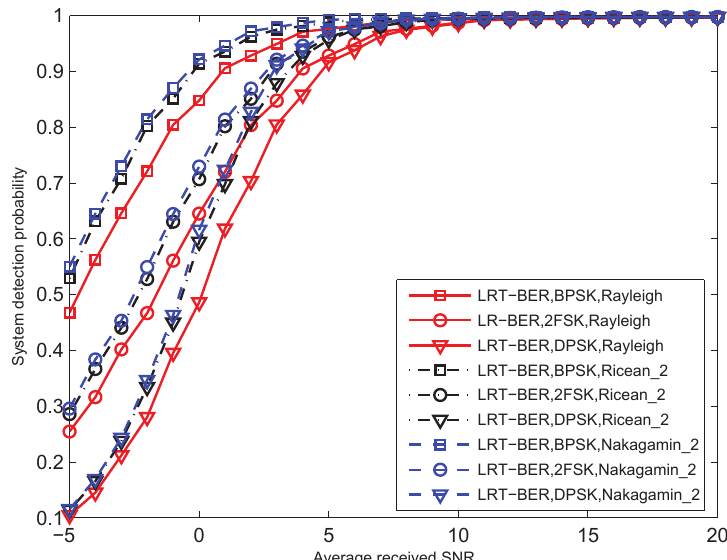
Figure 4. Detection probability of the LRT-BER fusion rule as a function of different received SNRs for BPSK, 2FSK and DPSK modulations with N = 20. Rayleigh fading, Ricean fading with factor K = 2 and Nakagami- m fading with m = 2 are considered. P = 0 . 1 , P = 0 . 6 , and P = 0 . 01 . fa d FA